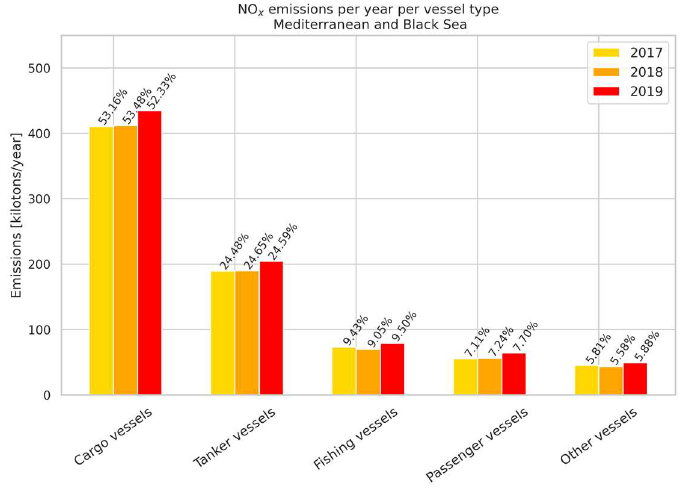
Figure 6 . CAMS-GLOB-SHIP NO X emissions (in kilotons y −1 ) per vessel type and year in the Medi- Figure 6. CAMS-GLOB-SHIP NO X emissions (in kilotons y − 1 ) per vessel type and year in the terranean and the Black Sea. Mediterranean and the Black